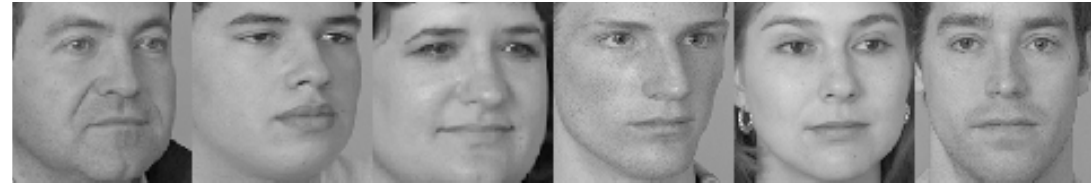
Figure 14. Sample images from the FERET face image database.